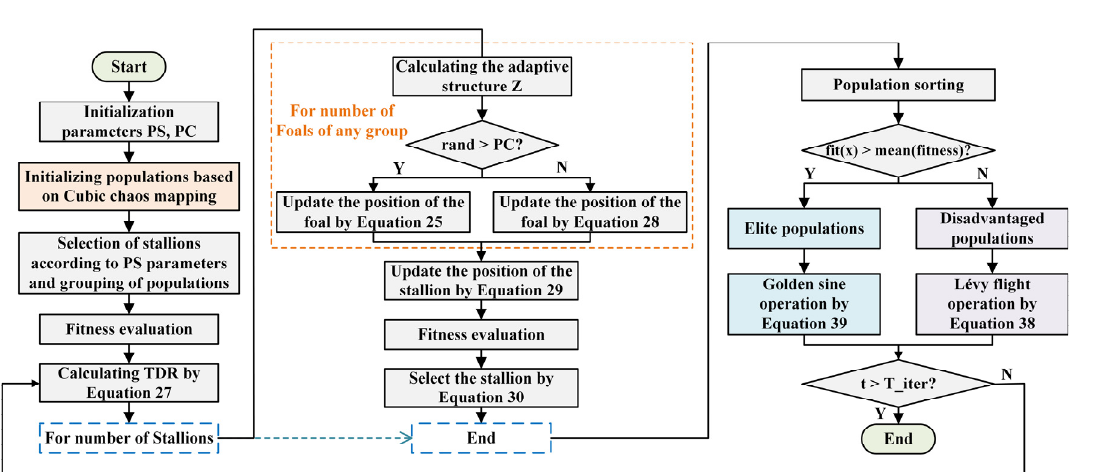
Table 1. Shanghai–Nanjing intercity railroad line data.